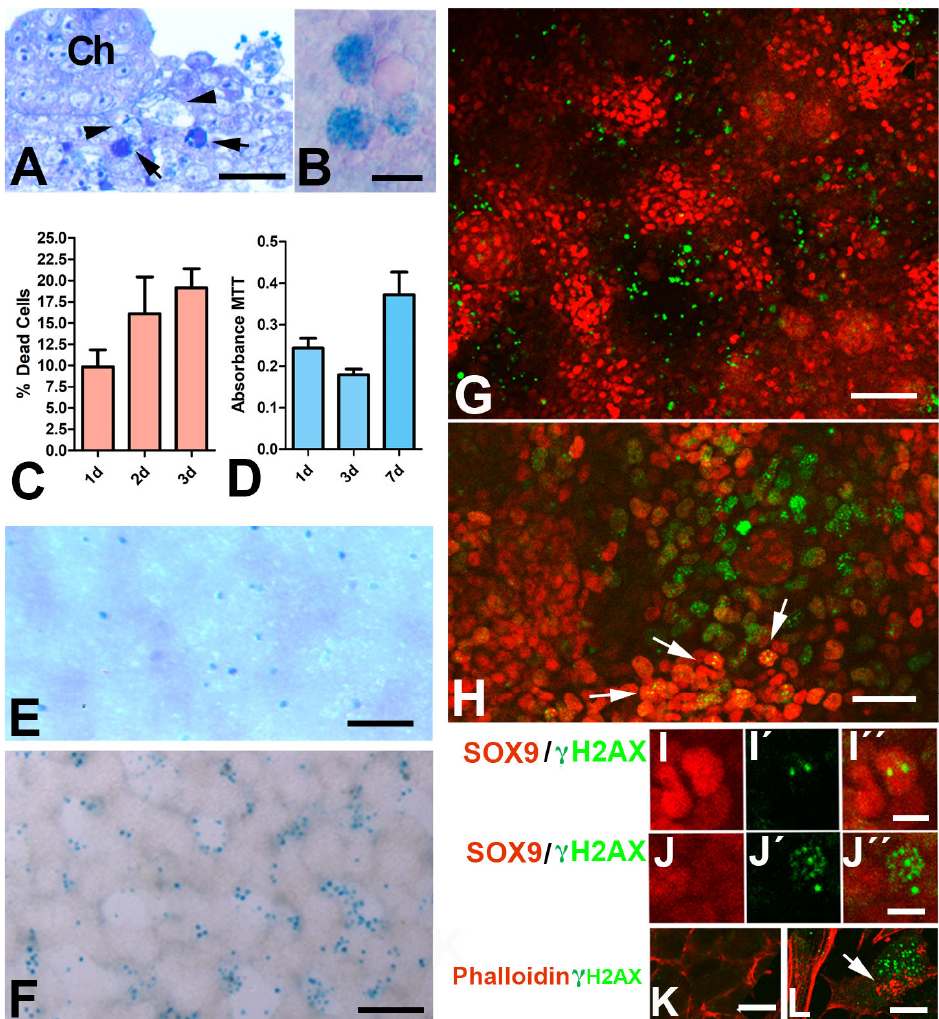
Figure 2. ( A ) Semithin section of a 3-day-old culture showing the presence of dark apoptotic cells (arrows) and vacuolated senescent cells (arrowheads) around a chrondrogenic nodule (Ch). ( B ) Detailed view of a micromass tissue showing senescent cells positive for SA β -gal histochemistry (eosin counterstaining). ( C ) Graphic representation of the rate of cell death evaluated by flow cytometry during the first 3 days of culture grown in DMEM-only. ( D ) Total tissue mass of micromass cultures at Days 1, 3, and 7 evaluated by MTT staining. ( E ) Low-magnification view of 1-day culture after SA β -gal histochemistry (dark blue staining) showing the distribution of senescent cells. ( F ) Perinodular restricted distribution of senescent cells positive for SA β -gal in a 3-day-old micromass. ( G ) Optical section of 3-day-old micromass showing the arrangement of apoptosis (green TUNEL labeling) in the perinodular tissue. Note the intense positivity for SOX9 (red labeling) in chondrogenic aggregates. ( H ) A 3-day-old micromass section immunolabeled for γ H2AX (green) and SOX9 (red) to show the preferential distribution of γ H2AX in perinodular tissue. Note the very reduced nuclear yH2AX labeling in the aggregated cells highly positive for SOX9 (arrows). ( I – I” ) Detailed view of a SOX9-positive cell ( I ) with a couple of dots positive for γ H2AX ( I’ ). ( I” ) is the merged image. (J – J”) Detailed view of an internodular cell with poor SOX9 labeling ( J ) but massive γ H2AX labeling ( J’ ). ( J” ) is the merged image ( J” ). ( K – L ) Single channel and merged image of double labeling with γ H2AX(green) and phalloidin (red) showing the aligned cytoplasmic actin filaments in healthy progenitors in contrast to the irregular aggregation of actin clumps (arrow) in the cytoplasm of cells highly positive for γ H2AX ( K ). Scale bar in A and H = 20 µ m; scale bar in B = 25 µ m; scale bar in E and F = 300 µ m; scale bar in G = 100 µ m; scale bar I-J-K-L= 5 µ m.